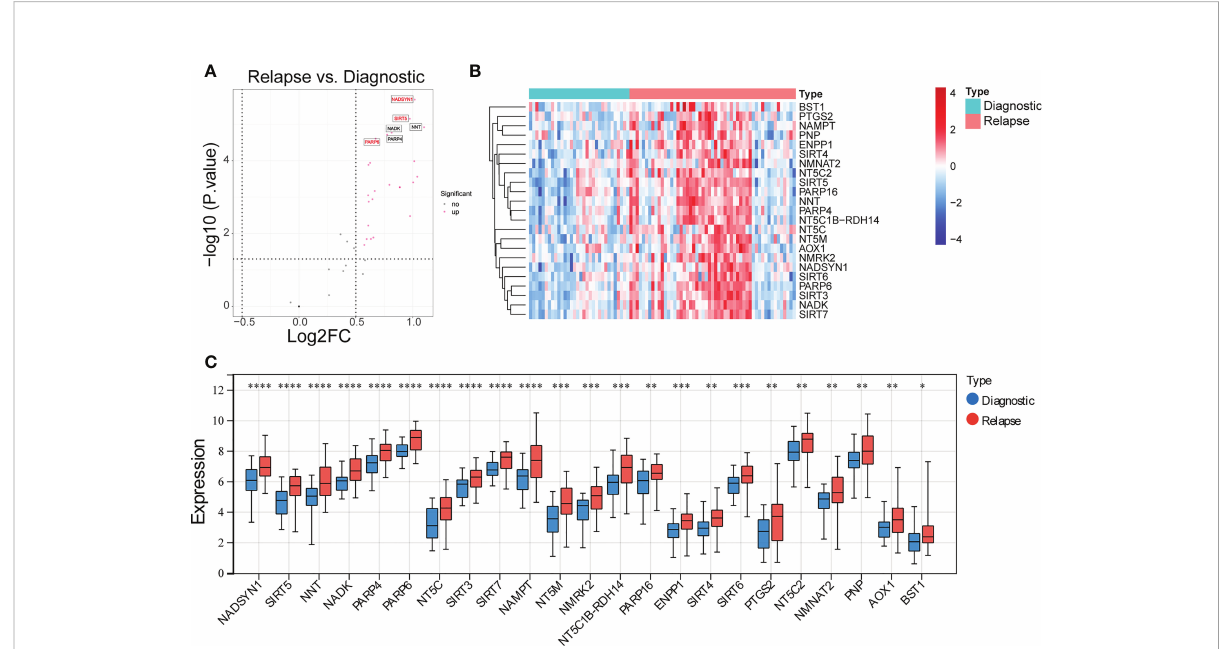
FIGURE 1 Identi fi cation of differentially expressed NAD+ metabolization-related genes (DE-NMRGs). (A) Volcano plot of DE-NMRGs between initially diagnosed and relapse samples, the red dots indicate up-regulated genes with the thresholds of |log2FC| > 0.5 and p < 0.05. (B) Heatmap of 23 DE-NMRGs in GSE3912. (C) The expression pro fi le of 23 DE-NMRGs in GSE3912. * represents p < 0.05, ** represents p < 0.01, *** represents p< 0.001, **** represents p <